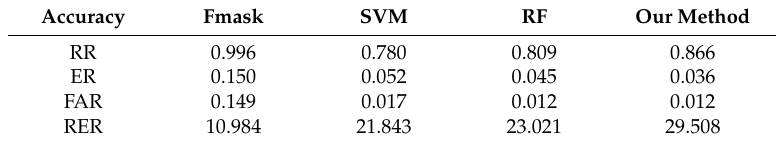
Table 4. Cloud detection accuracy for SVM, RF and our proposed method with Landsat images.